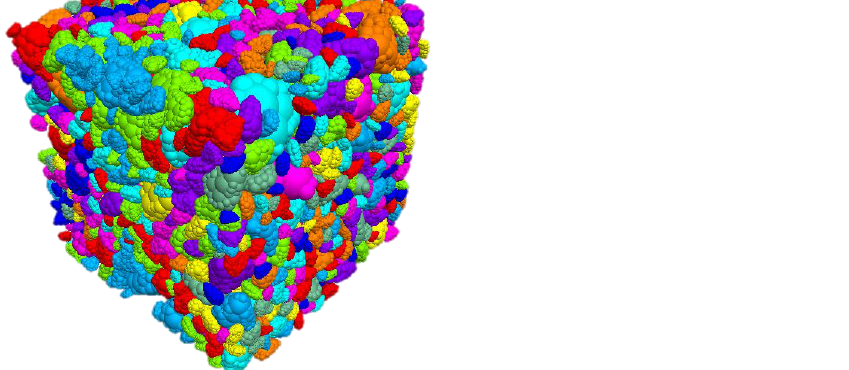
Figure 4. Example of aggregate positions in the three-dimensional heterogeneous model.